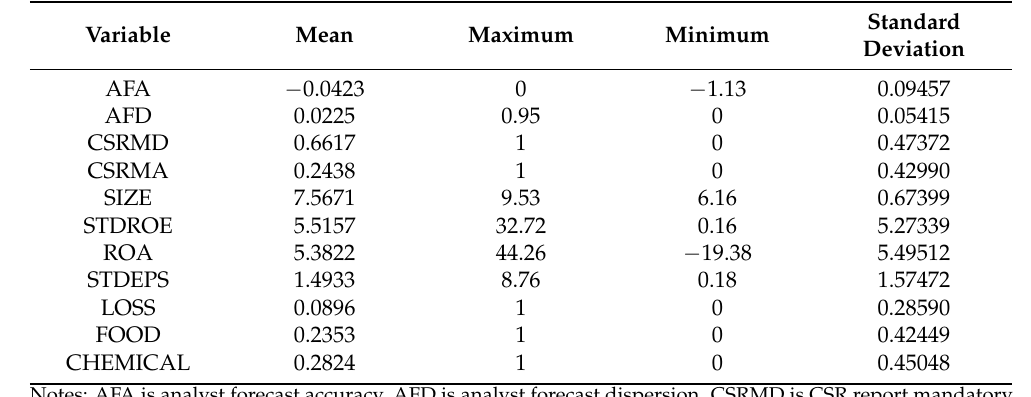
Table 2. Descriptive statistics.